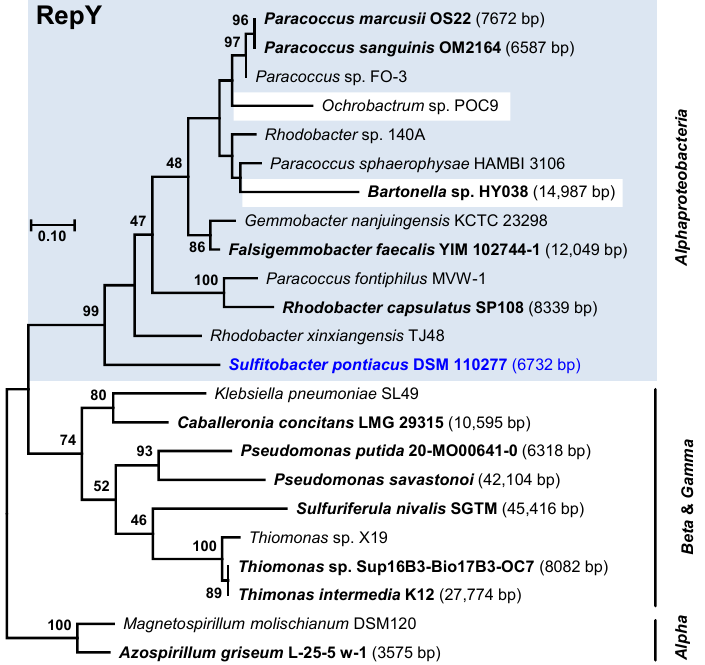
Figure 4. Phylogenetic Maximum Likelihood tree of 23 RepY type plasmid replication proteins based on 157 amino acid positions. Bootstrap support > 40% is indicated. The replicase of Sulfitobacter pontiacus DSM 110277 is shown in blue. Circular plasmids or circularized contigs are highlighted in bold. Sequences from Rhodobacterales are highlighted by a blue box. Accession numbers, localization, and further characteristics of RepY type replicases are presented in Table S3B.